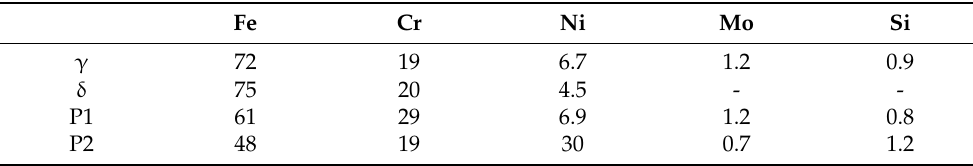
Figure 11. Color mapping in HAZ (1) and fusion zone (2): ( a ) SEM picture in HAZ ( b ) EDS mapping in HAZ ( c ) SEM picture in FZ, and ( d ) EDS mapping in FZ. Table 4. Results of the EDS analysis for the phases and precipitates.